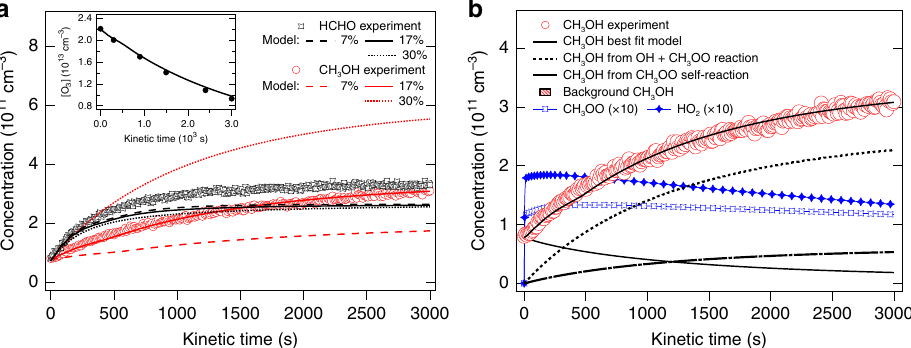
Fig. 3 Measured and modelled methanol and formaldehyde time pro fi les. a Full lines with model from Supplementary Table 1 (adjusted to O 3 decay rate, inset) with ϕ CH3OH = 17%, dotted line ϕ CH3OH = 30%, dashed line ϕ CH3OH = 7%. b The solid black line shows the modelled CH 3 OH concentration with major contributions being production from self-reaction (dashed-dotted line) and reaction of CH 3 OO + OH (dashed line) and removal by the reaction of CH 3 OH with OH. HO 2 and CH 3 O 2 concentrations from the model are also shown